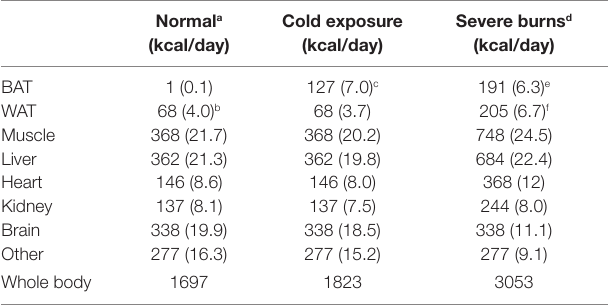
TABLe 1 | impact of acute non-shivering cold exposure and severe burns on whole-body energy